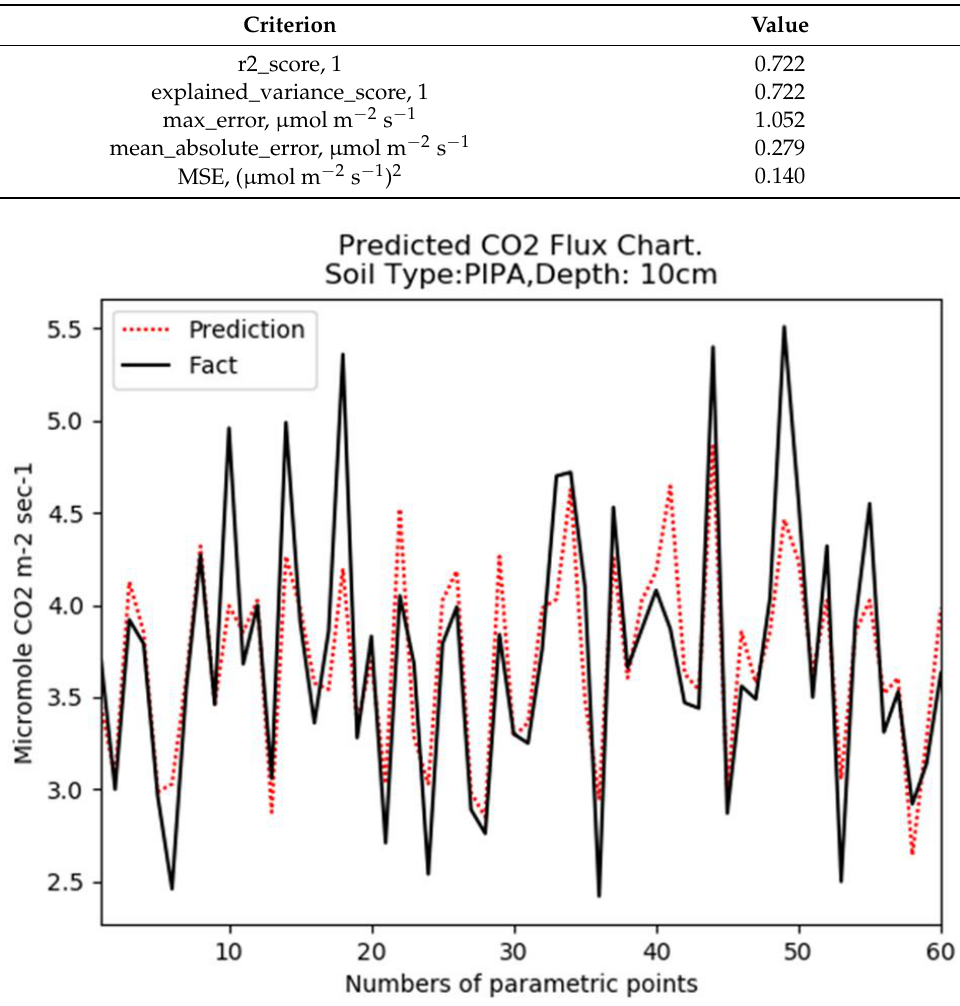
Figure 2. Regression approximation results in experiment 1.